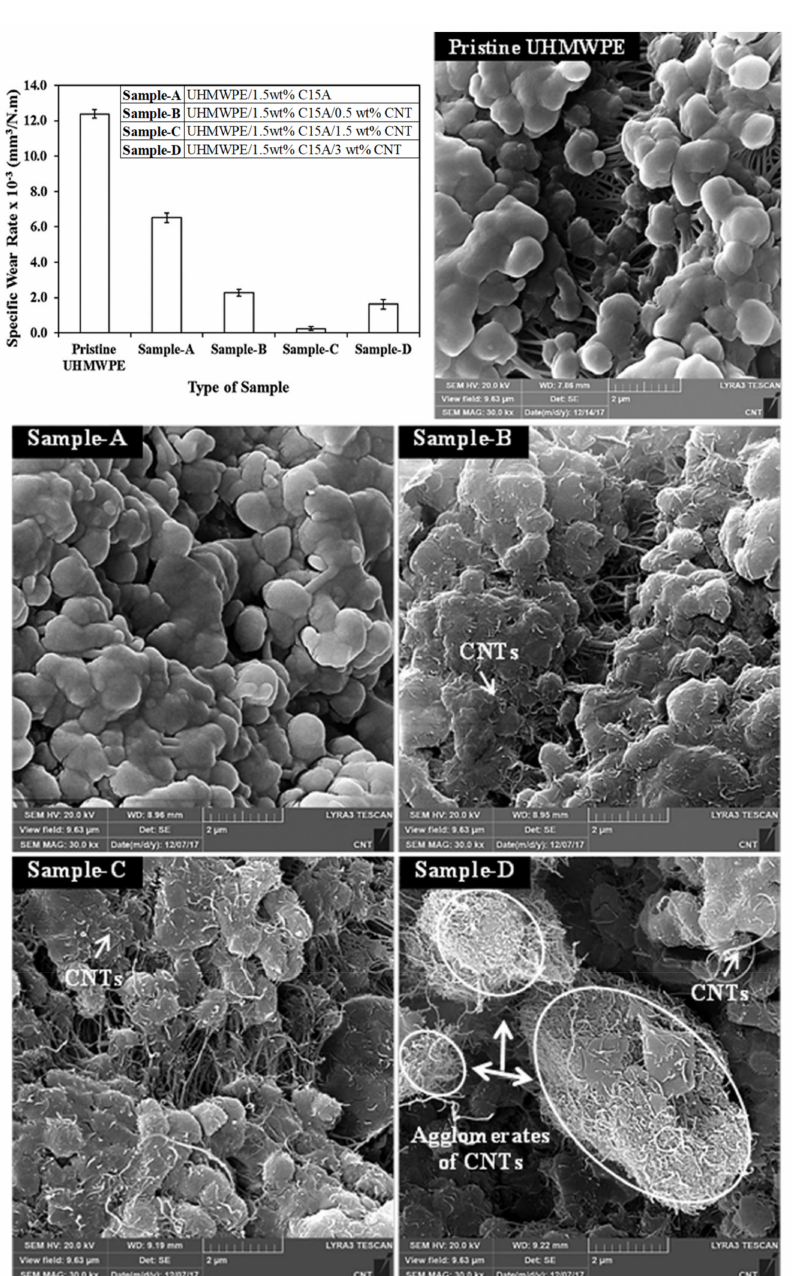
Figure 10. Comparison of specific wear rates of the different coatings at a load of 12 N and a sliding speed of 0.1 m/s. SEM Micrographs of different samples showing the dispersion [75].